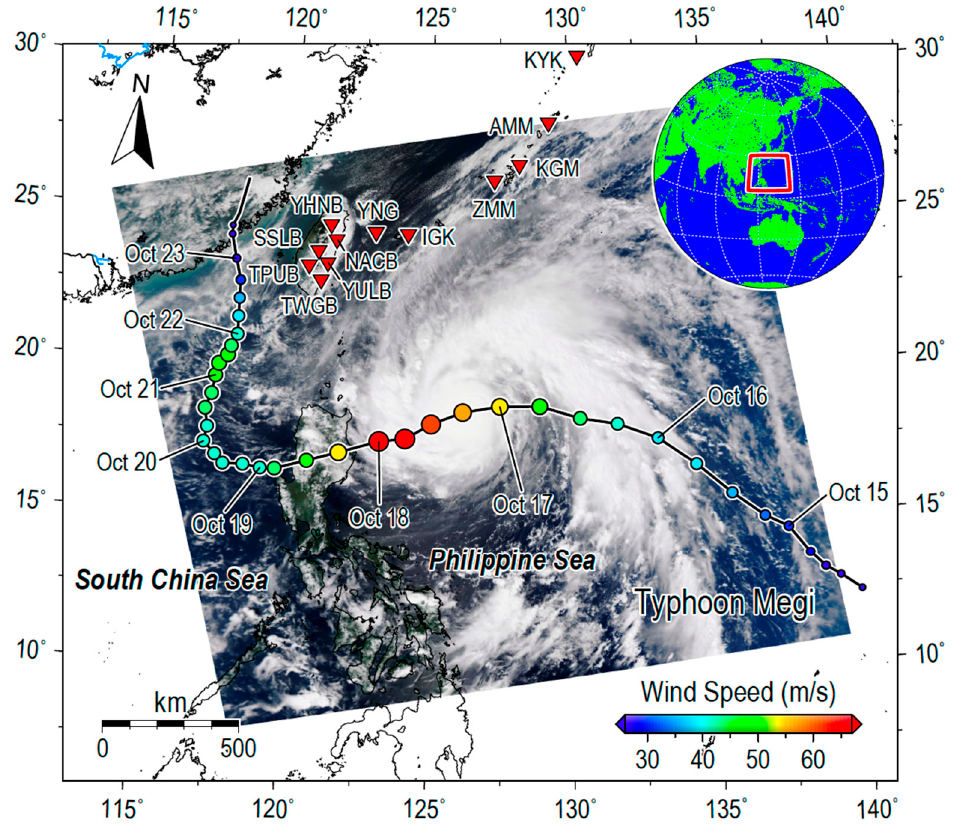
Figure 1. Distribution of seismic stations (red triangles) and trajectory of Typhoon Megi (colored circles) in the western Pacific Ocean, with a superimposed Quick-Look image of Megi captured by Modis on 17 October 2010 at 04:55 coordinated universal time (UTC) (https://ladsweb.modaps.eosdis.nasa.gov). The seismic stations are mostly from the Broadband Array in Taiwan for Seismology (BATS) and the F-net network of Japan. The typhoon track is indicated by rounded circles, equally spaced in time at six-hour intervals, with circle size and color related to wind speed. The best-track data of Megi were provided by the Japan Meteorological Agency